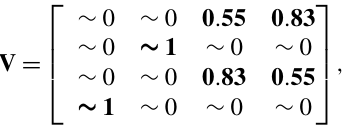
8 ◦ and κ h 0 . 1 (b) , upflow angle χ at φ = = −